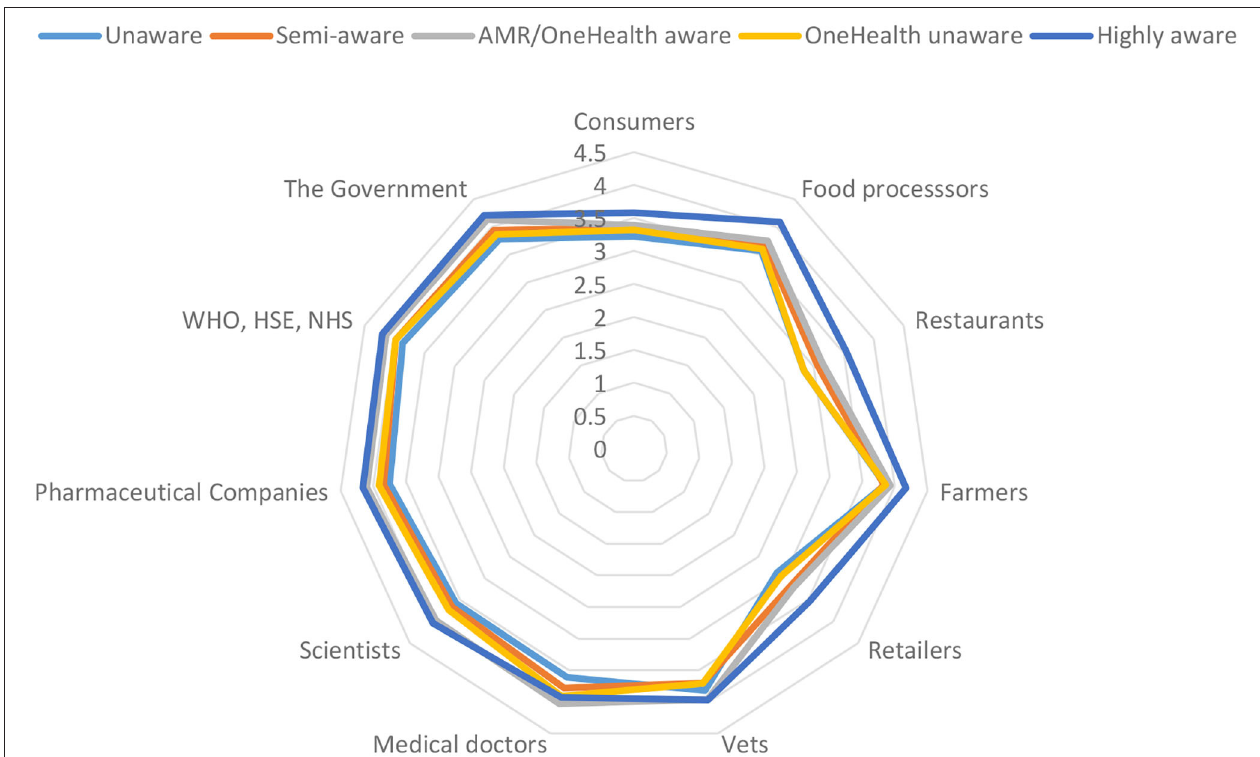
FIGURE 2 | Attributions of responsibility for tackling AMR across five clusters of consumers, categorised based on perceived impact of Covid-19 on awareness of AMR, OneHealth, and welfare information on labels ( n =